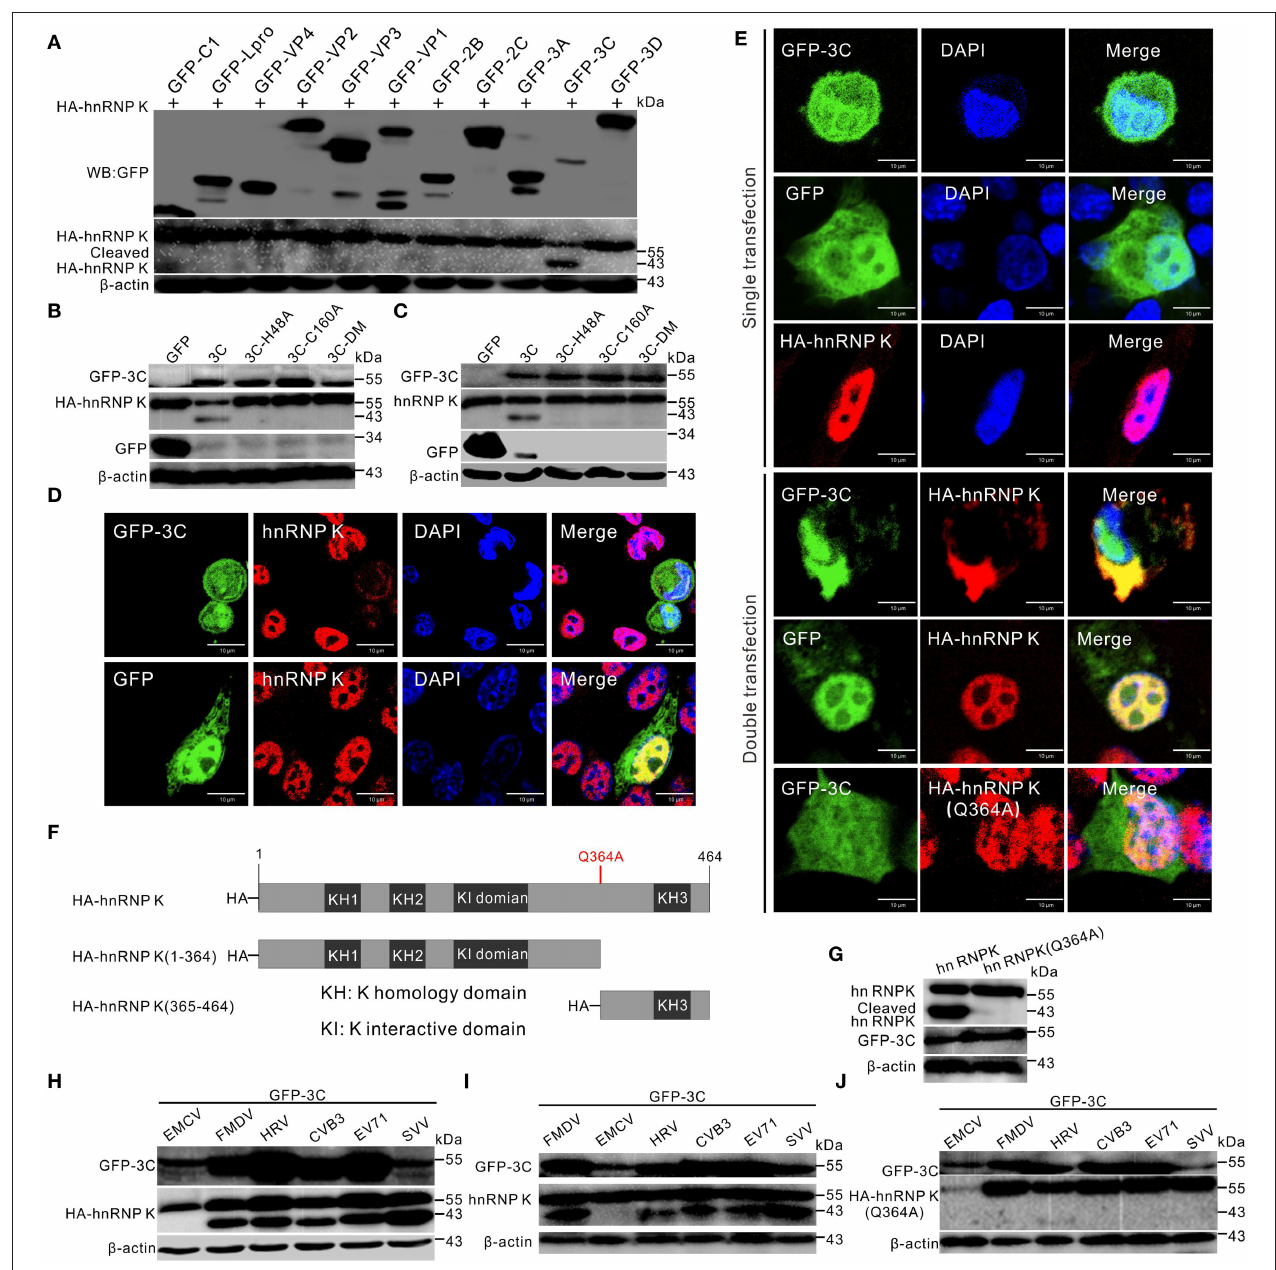
FIGURE 3 | SVV 3C pro cleaves hnRNP K. (A) BHK-21 cells were cotransfected with HA-hnRNP K and GFP-viral gene plasmids, the cells were collected by Western blotting analysis at 24h post-transfection (hpt). (B) BHK-21 cells in six-well plates were cotransfected with HA-hnRNP K and GFP empty vector, GFP-3C, GFP-3C-H48A, GFP-3C-C160A, or GFP-3C-DM. The cell lysates were subjected to Western blotting at 24 hpt. (C) BHK-21 cells in six-well plates were transfected with GFP empty vector, GFP-3C, GFP-3C-H48A, GFP-3C-C160A, or GFP-3C-DM. The cell lysates were subjected to Western blotting at 24 hpt. (D) BHK-21 cells were transfected with GFP-3C (green) and GFP vector (green) and stained with antibodies against hnRNP K (red) and DAPI (blue), captured under confocal microscopy. (E) BHK-21 cells were single- or double- transfected with GFP-3C (green), GFP vector (green), HA-hnRNP K, or HA-hnRNP K (Q364A), stained with antibodies against HA (red) and DAPI (blue), captured under confocal microscopy. (F) Domain organization and engineering of truncation constructs of HA-hnRNP K. KH, K homology domain; KI, interactive domain. (G) BHK-21 cells were cotransfected with HA-hnRNP K and HA-hnRNP K (Q364A) with GFP-3C. The cells were collected by Western blotting at 24 hpt. (H) HA-hnRNP K was cotransfected with GFP-3C of EMCV, FMDV, HRV, CVB3, EV71, and SVV plasmids into BHK-21 cells, the cells were collected by Western blotting at 24 hpt. (I) BHK-21 cells were transfected with GFP-3C of EMCV, FMDV, HRV, CVB3, EV71, and SVV plasmids into BHK-21 cells, the cells were collected by Western blotting at 24 hpt. (J) HA-hnRNP K (Q364A) was cotransfected with GFP-3C of EMCV, FMDV, HRV, CVB3, EV71, and SVV plasmids into BHK-21 cells, the cells were collected by Western blotting at 24 hpt.